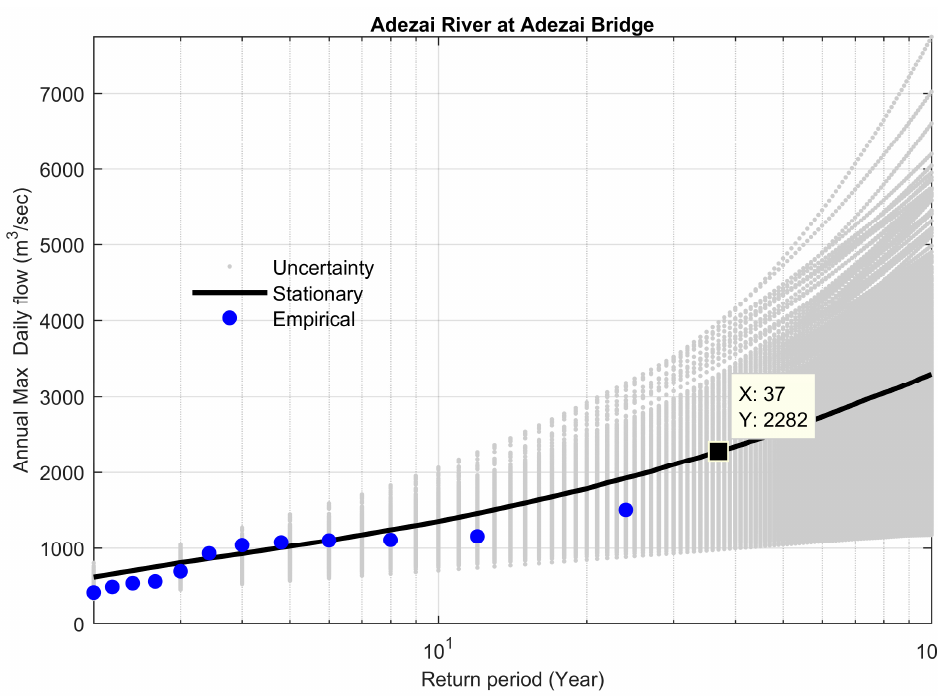
Figure 13. FFCs at site 5, along with stationary uncertainty bounds for the year 2009.